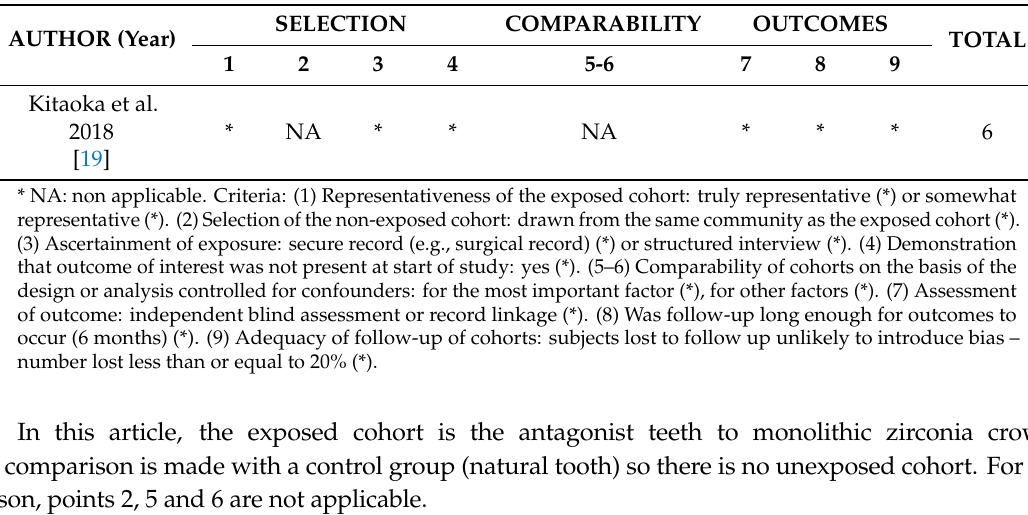
Table 1. Quality of the studies in the Newcastle–Ottawa scale for cohort studies.